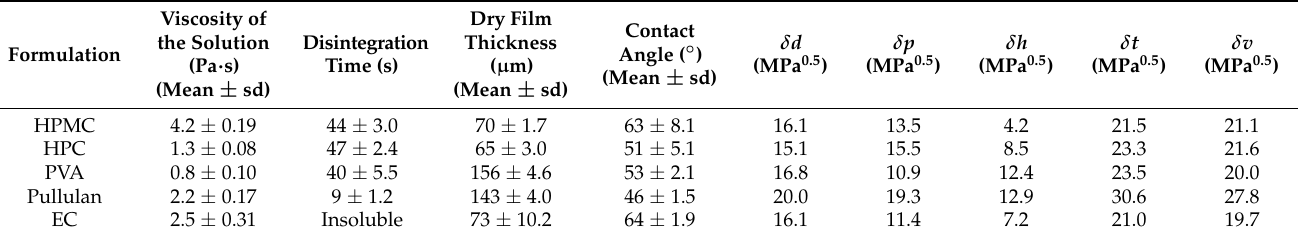
Table 7. Properties of the used polymers and respective pre-casting solutions and films prepared for the mechanical characterization of tandem